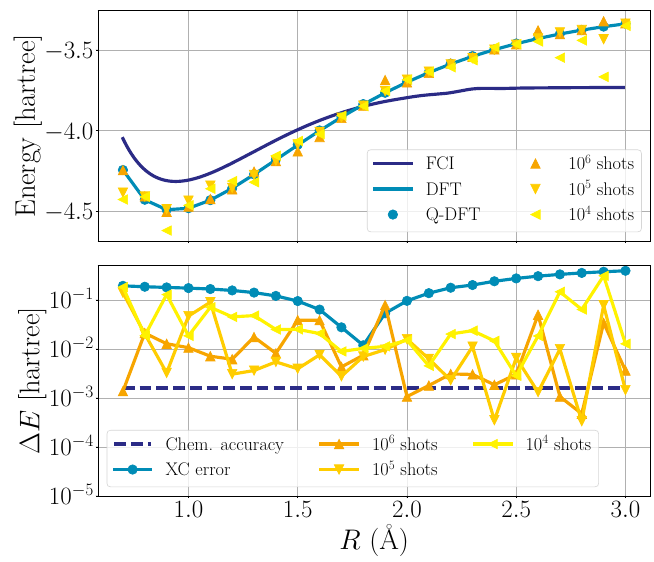
Figure 5: Top panel: Ground-state energy of the H interatomic distance, in hartree. Bottom panel: Absolute error between Q-DFT and DFT energies when sampling noise is considered. They are compared to the chemical accuracy and the XC